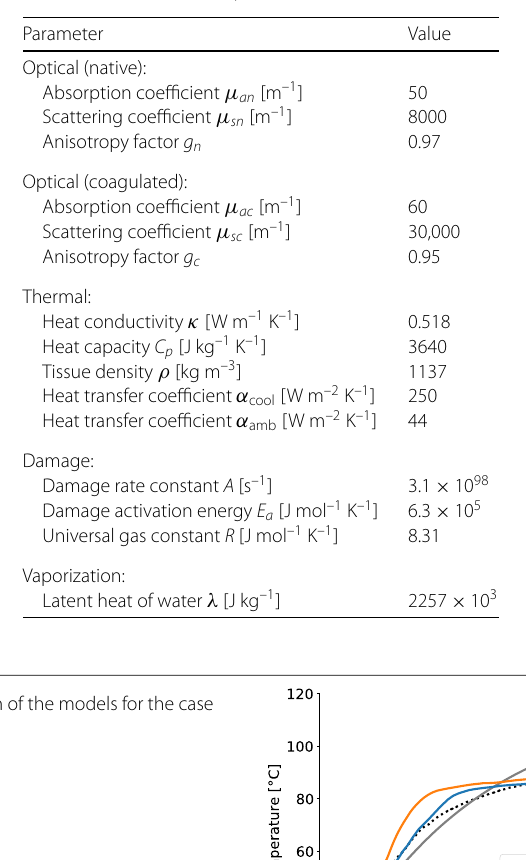
Table 2 Physical parameters for LITT in ex-vivo porcine liver tissue